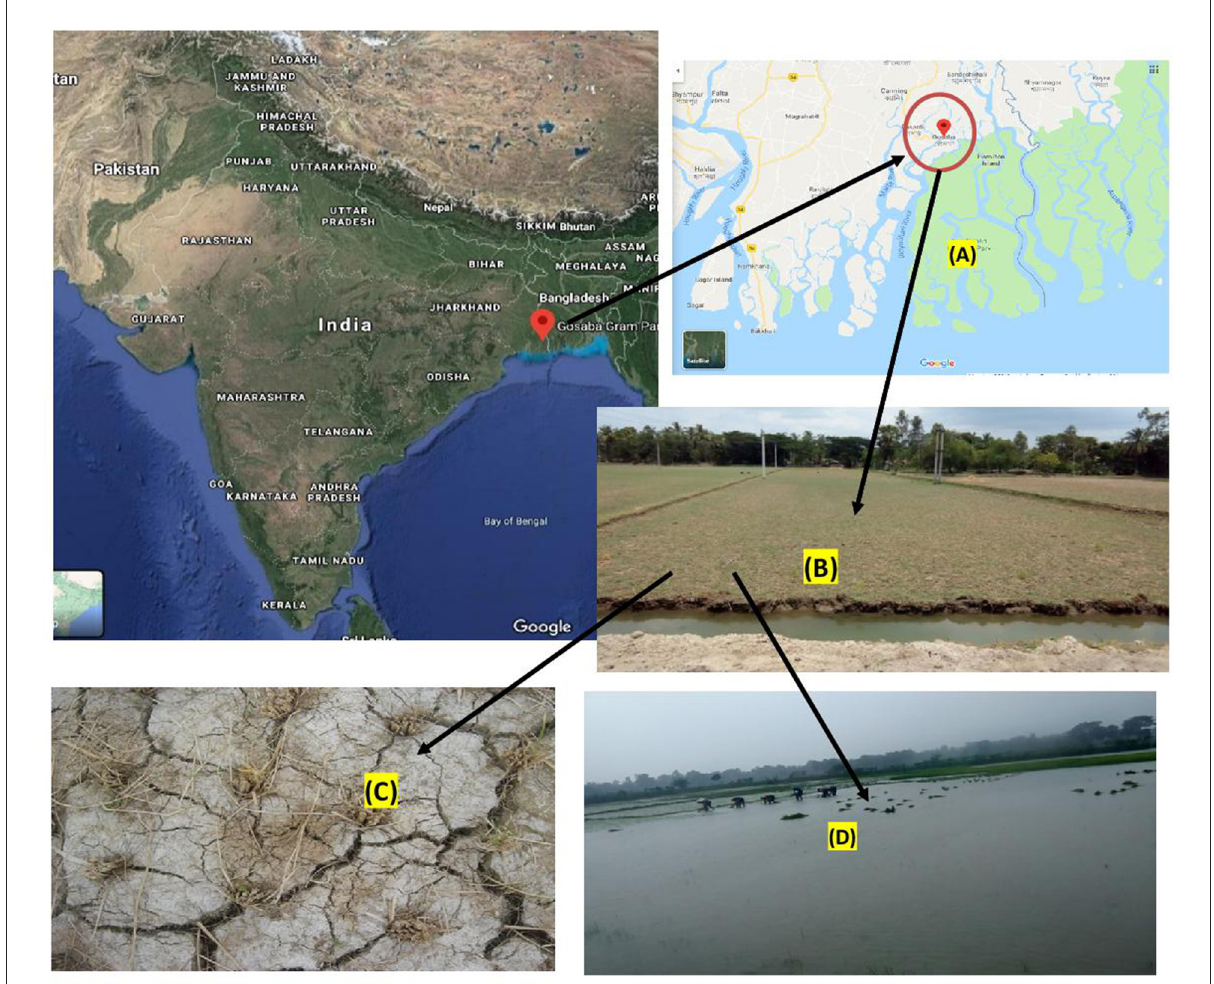
FIGURE1 Location of the study area (A) and the physiography (B) of the coastal zone during rabi (dry/winter) (C) and kharif (wet/rainy) season (D)